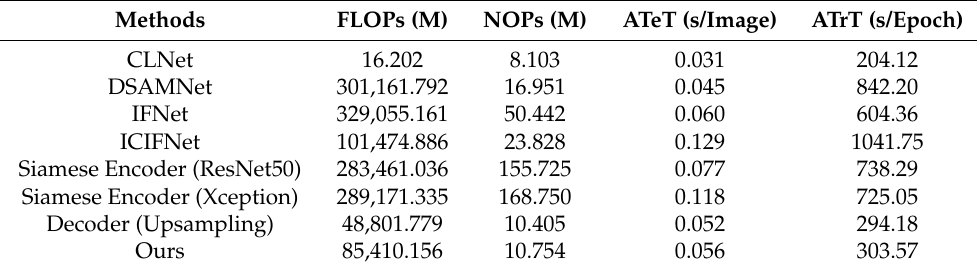
Table 6. Comparison of the complexity of networks and computation cost on the WHUCD